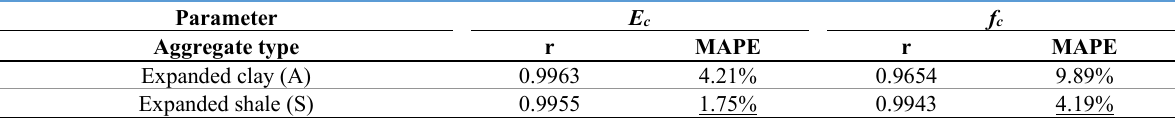
Table 5 S tatistical parameters of the correlation between the numerical and experimental data of each type of aggregate for Young’s modulus ( E c ) and compressive strength ( f c ).